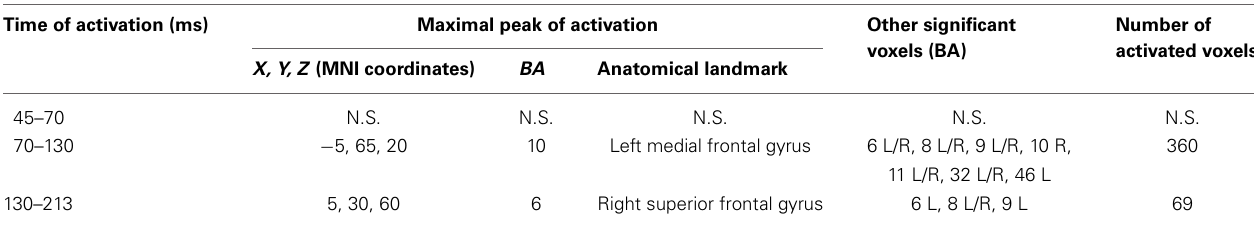
Table 4 | Results from discrete time windows sLORETA analysis (mean neural activity, log of F-ratio). Time of activation